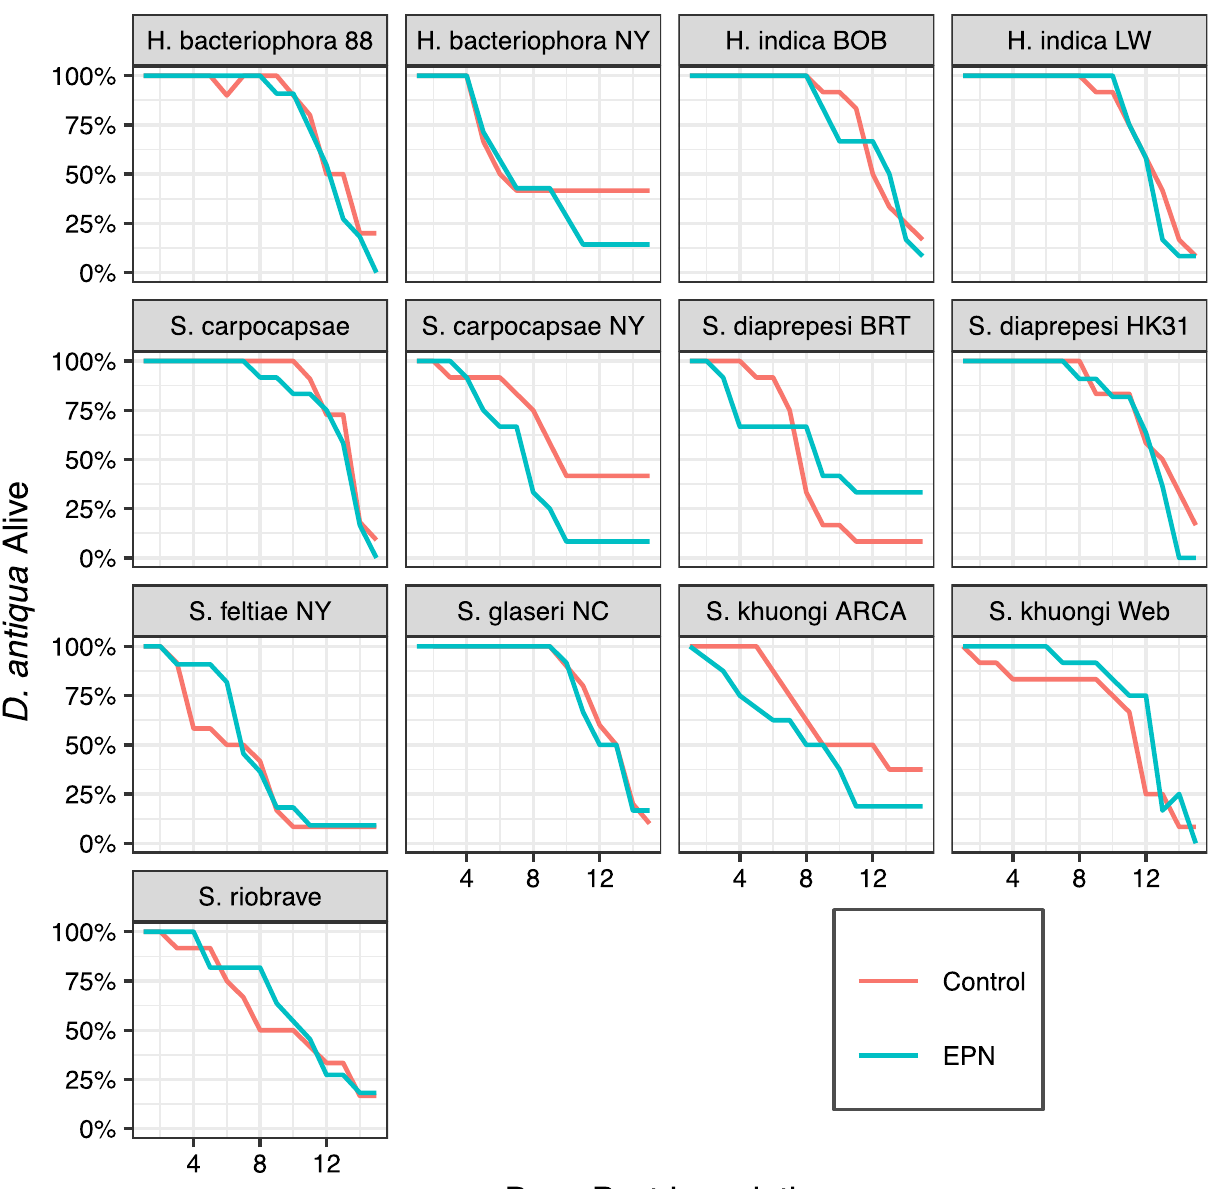
Figure 1. D. antiqua Survival following exposure to strains of entomopathogenic nematodes as pupae. Long- term survival appears to vary in a strain-dependent manner. Certain species seem to be more virulent and cause higher mortality in